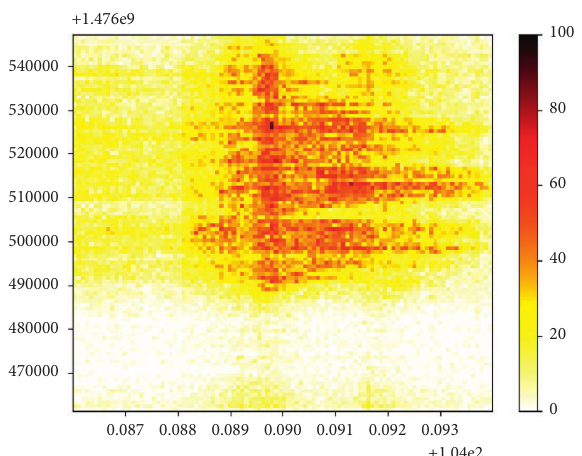
Figure 17: Daily variation of vehicle conflict risk in vehicle inflow section.